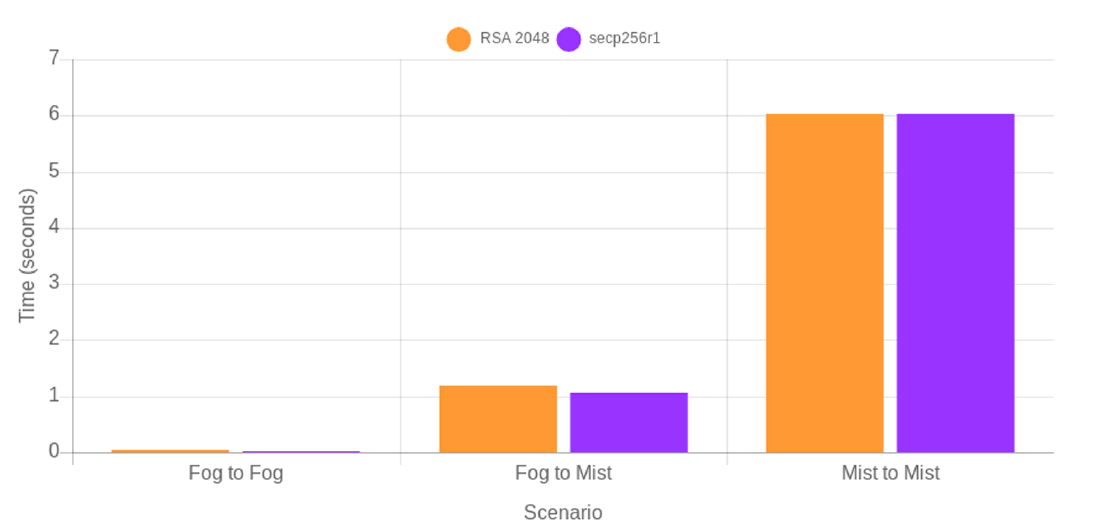
Figure 12. Time (seconds) per request for fog gateway to fog gateway, fog gateway to mist end-device, and mist end-device to mist end-device